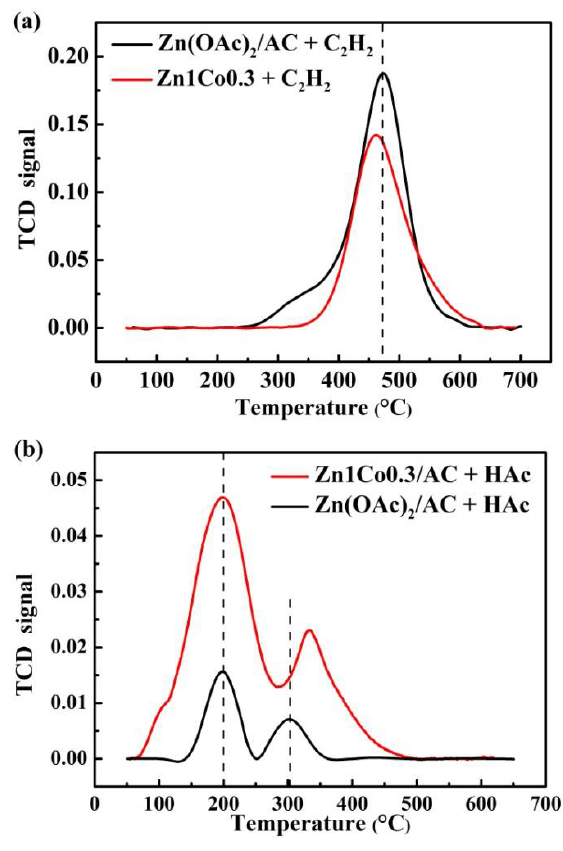
Figure 3. Temperature-programmed desorption profiles of fresh Zn1Co0.3/AC and Zn(OAc) 2 /AC with C 2 H 2 ( a ) and HAc ( b ).